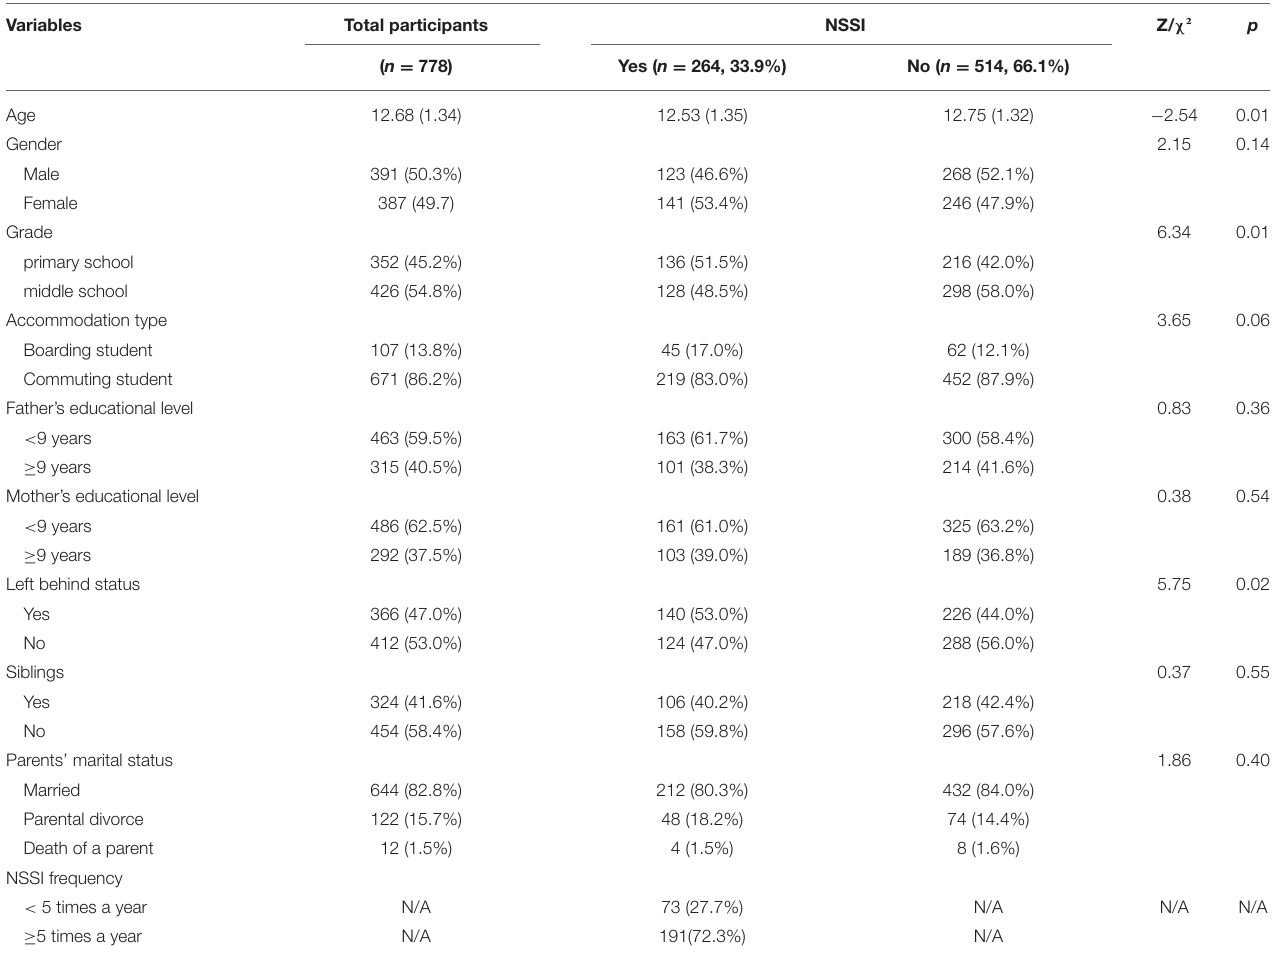
TABLE 1 | Social demographic characteristics of